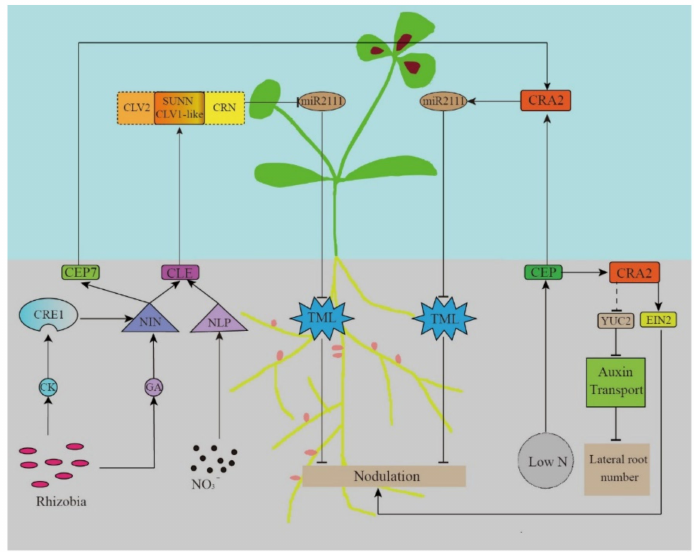
Figure 2. The AON systemic regulatory pathway